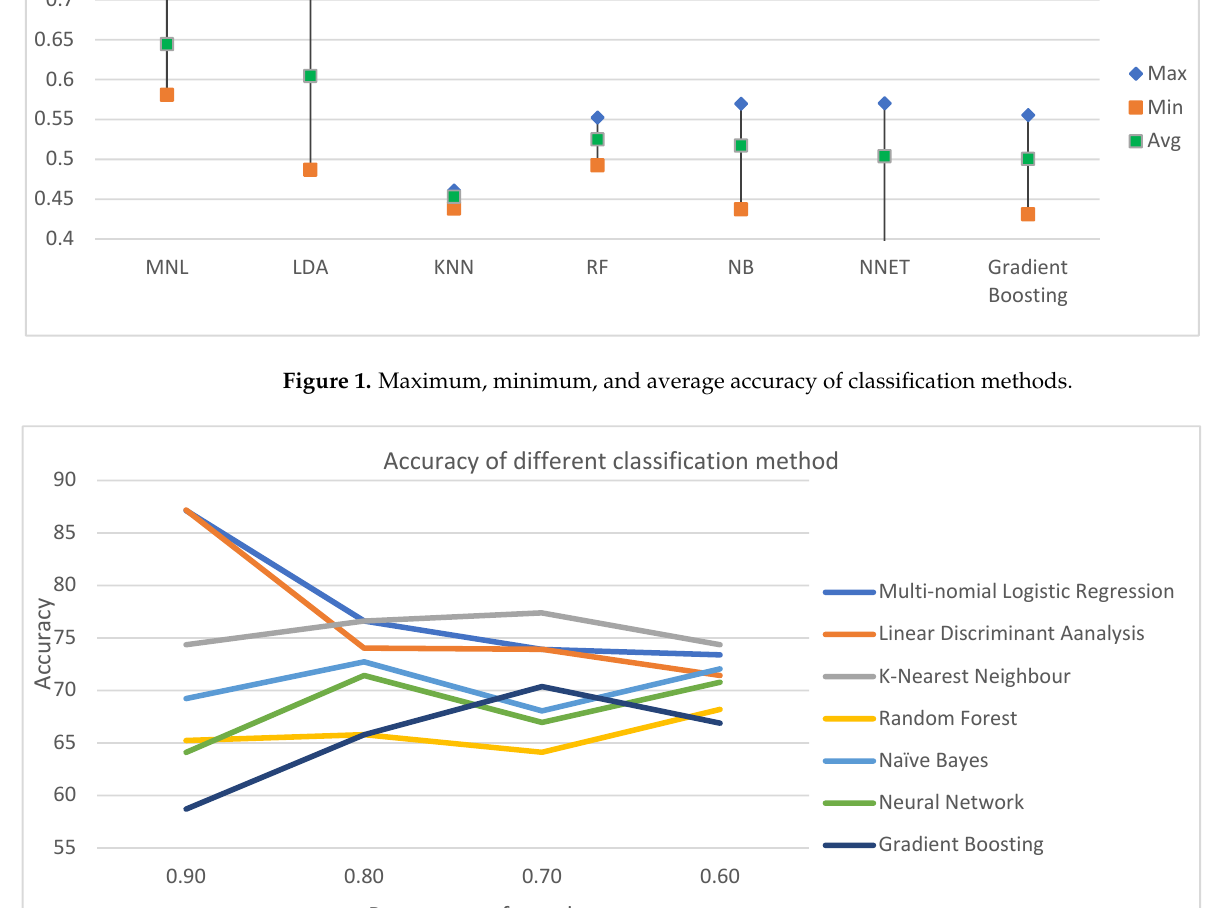
Figure 1. Maximum, minimum, and average accuracy of classification methods.